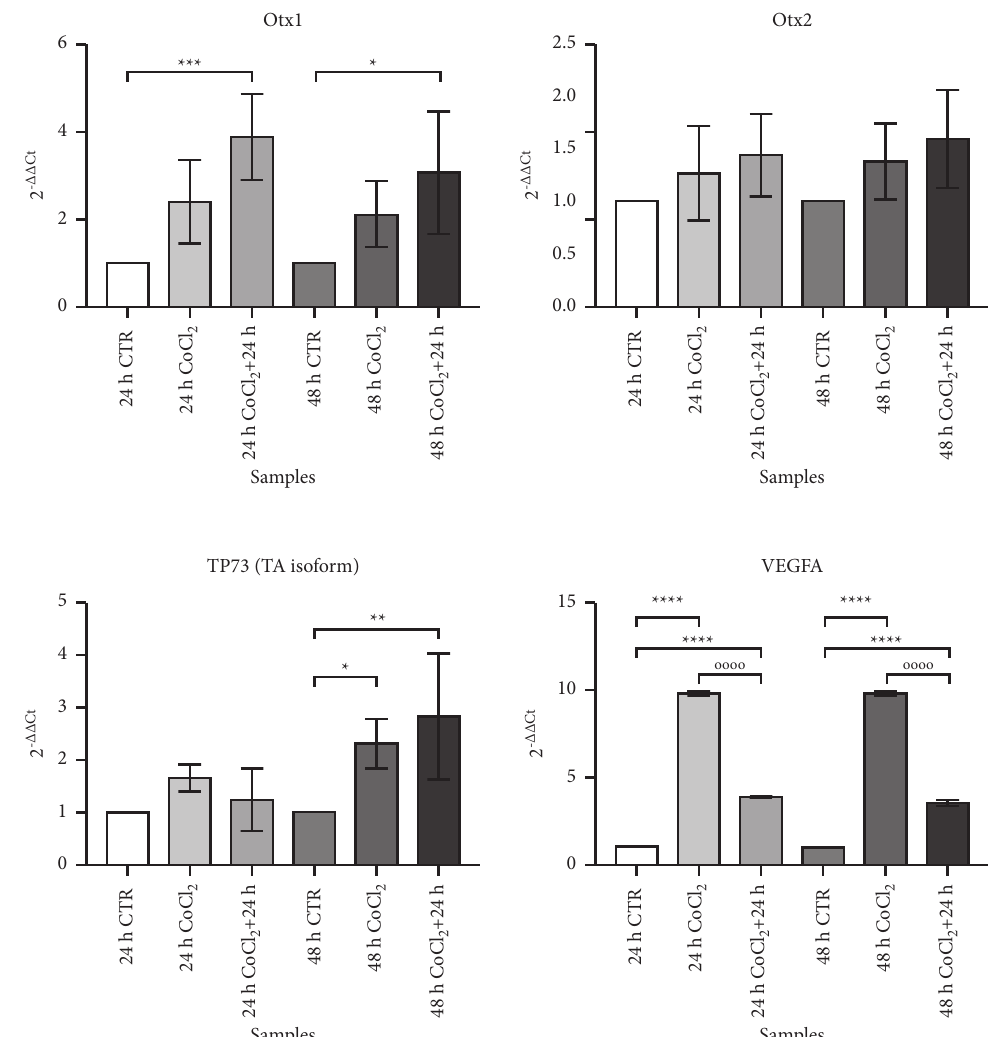
Figure 5: qRT-PCR on CTR- and CoCl 2 -treated MIO-M1 M¨uller cells. Each graph represents the expression levels of a single studied gene in different experimental conditions. All values are indicated as median ± SD. On the Y -axis, the fold change value is reported. Statistical analysis was performed by one-way ANOVA and Tukey’s post hoc test. ∗ p < 0.05; ∗∗ p < 0.01; ∗∗∗ p < 0.001; and ∗∗∗∗ p <